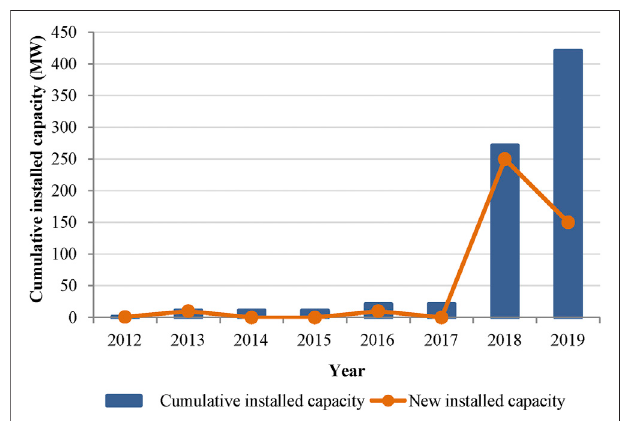
FIGURE 1 | New and cumulative installed capacities of China ’ s CSP from 2012 to